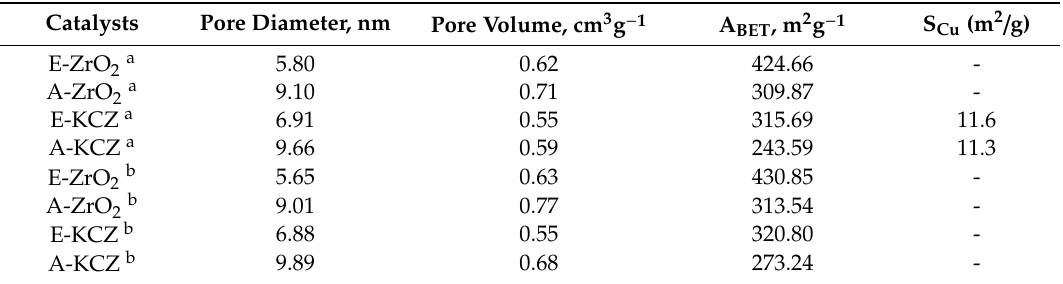
Table 3. Textural properties of calcined catalysts.